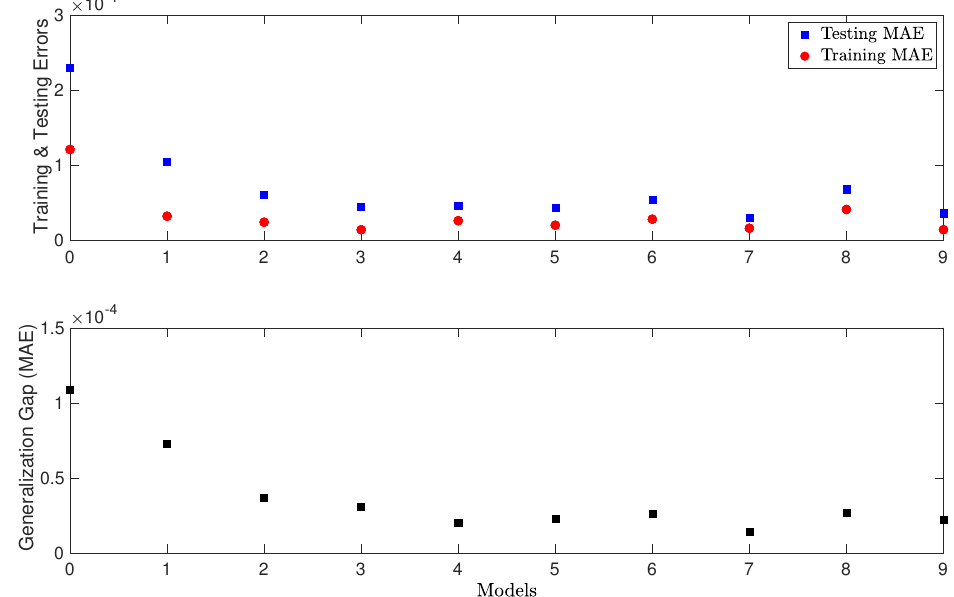
Figure 6. RNN generalization performance vs. different regions in Ω ˆ ρ